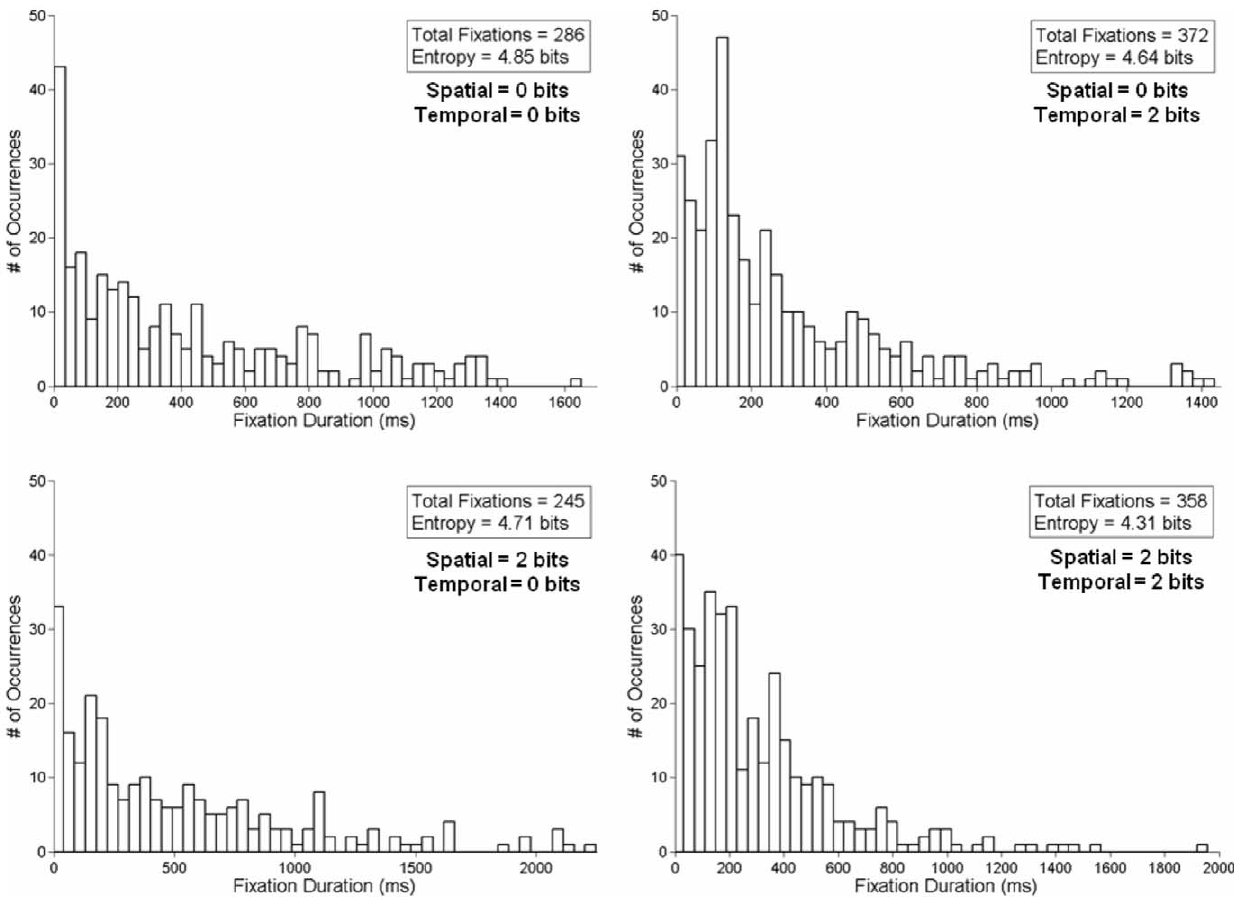
Figure 3. Exemplar probability distributions of fixation duration data. These data are from the same subject and conditions in Figure 2. Here, the total number of fixations within each trial block is presented alongside the entropy values, calculated using Eq. 1.